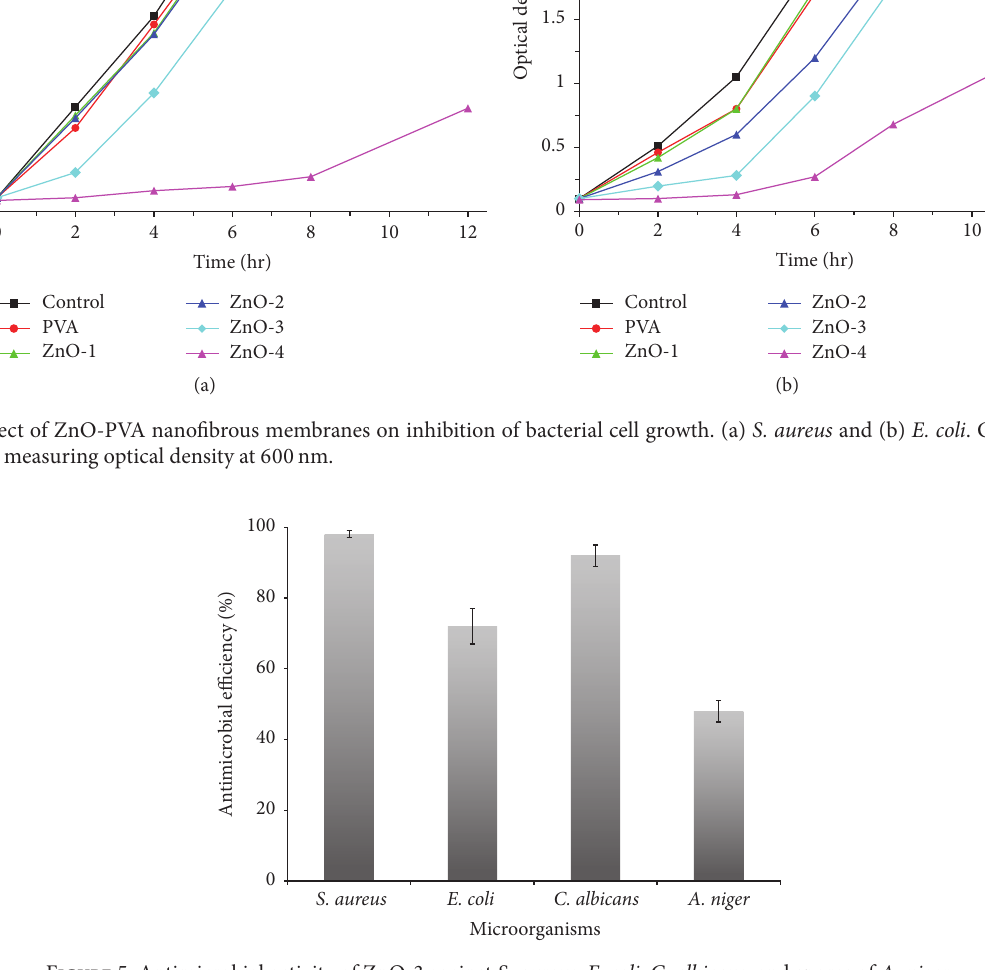
on Gram-positive microorganisms than on Gram-negative ones [16,